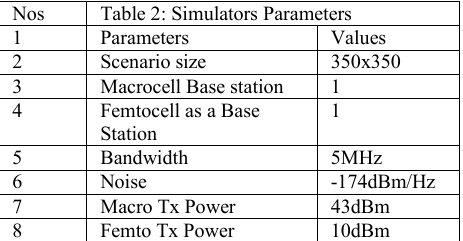
Table 2: Simulators Parameters 1